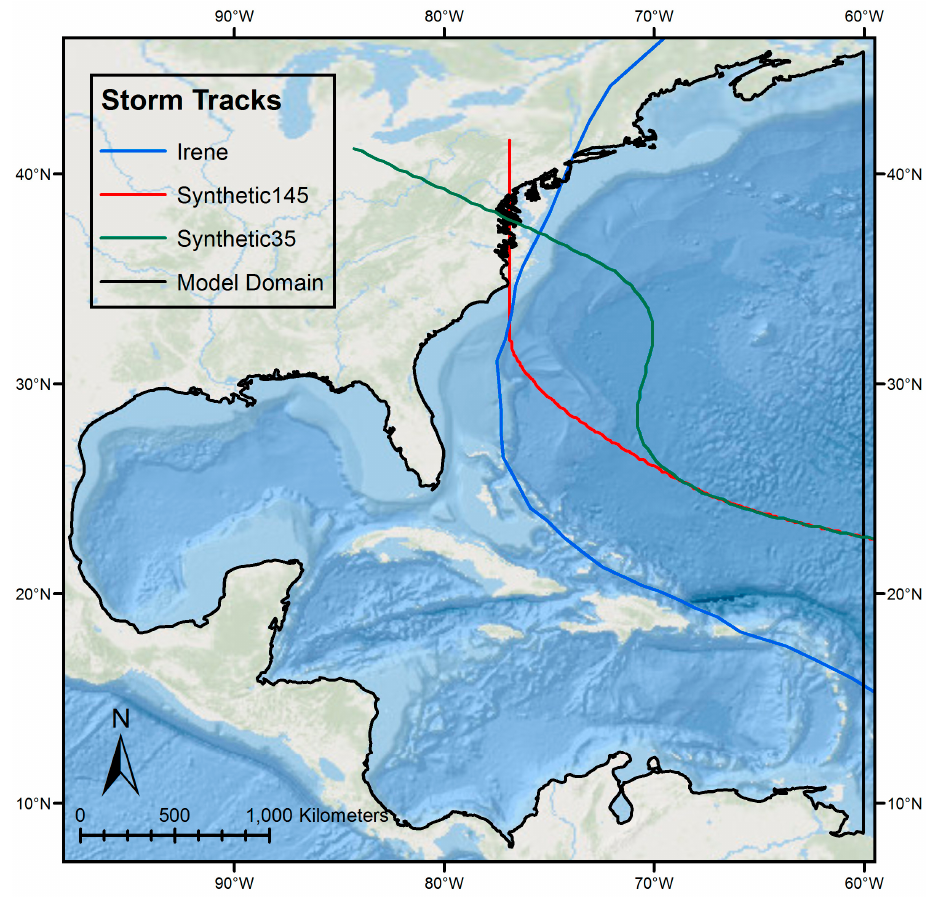
Figure 3. Numerical model domain and selected storm tracks. Table 3. Wind and pressure intensity of the selected storms.